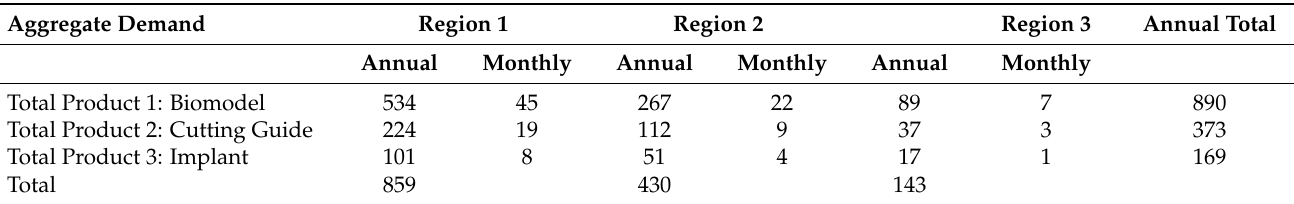
Table 1. Projected annual and monthly demand for medical